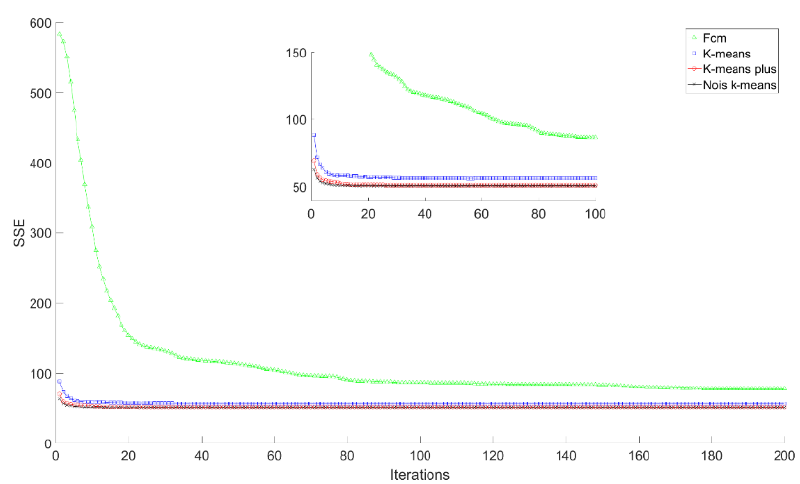
Figure 7. The SSE convergence curve for taxi GPS data (Chongqing (China)).